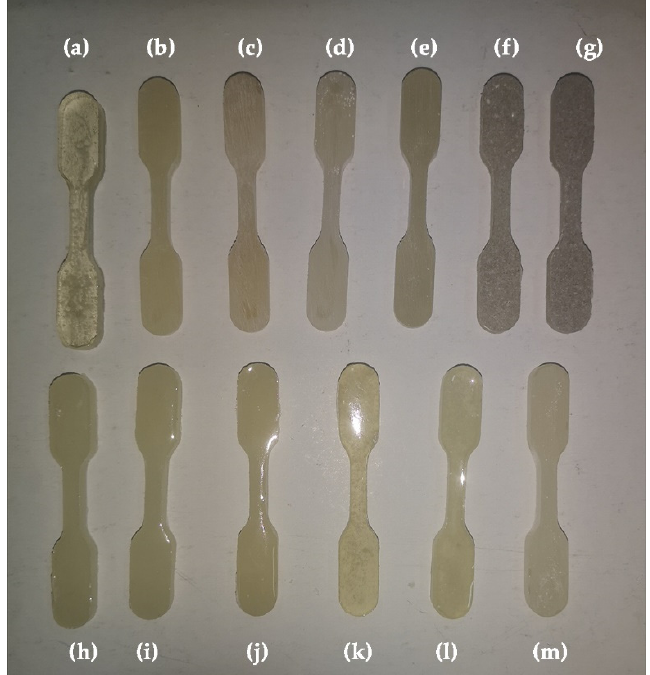
Figure 2. Plain epoxy and newly synthesized nanocomposites ( a ) PE, ( b ) PE/1DS, ( c ) PE/2DS, ( d ) PE/3DS, ( e ) PE/1MS, ( f ) PE/2MS, ( g ) PE/3MS, ( h ) PE/1TS, ( i ) PE/2TS, ( j ) PE/3TS, ( k ) PE/1W, ( l ) PE/2W, and ( m ) PE/3W.